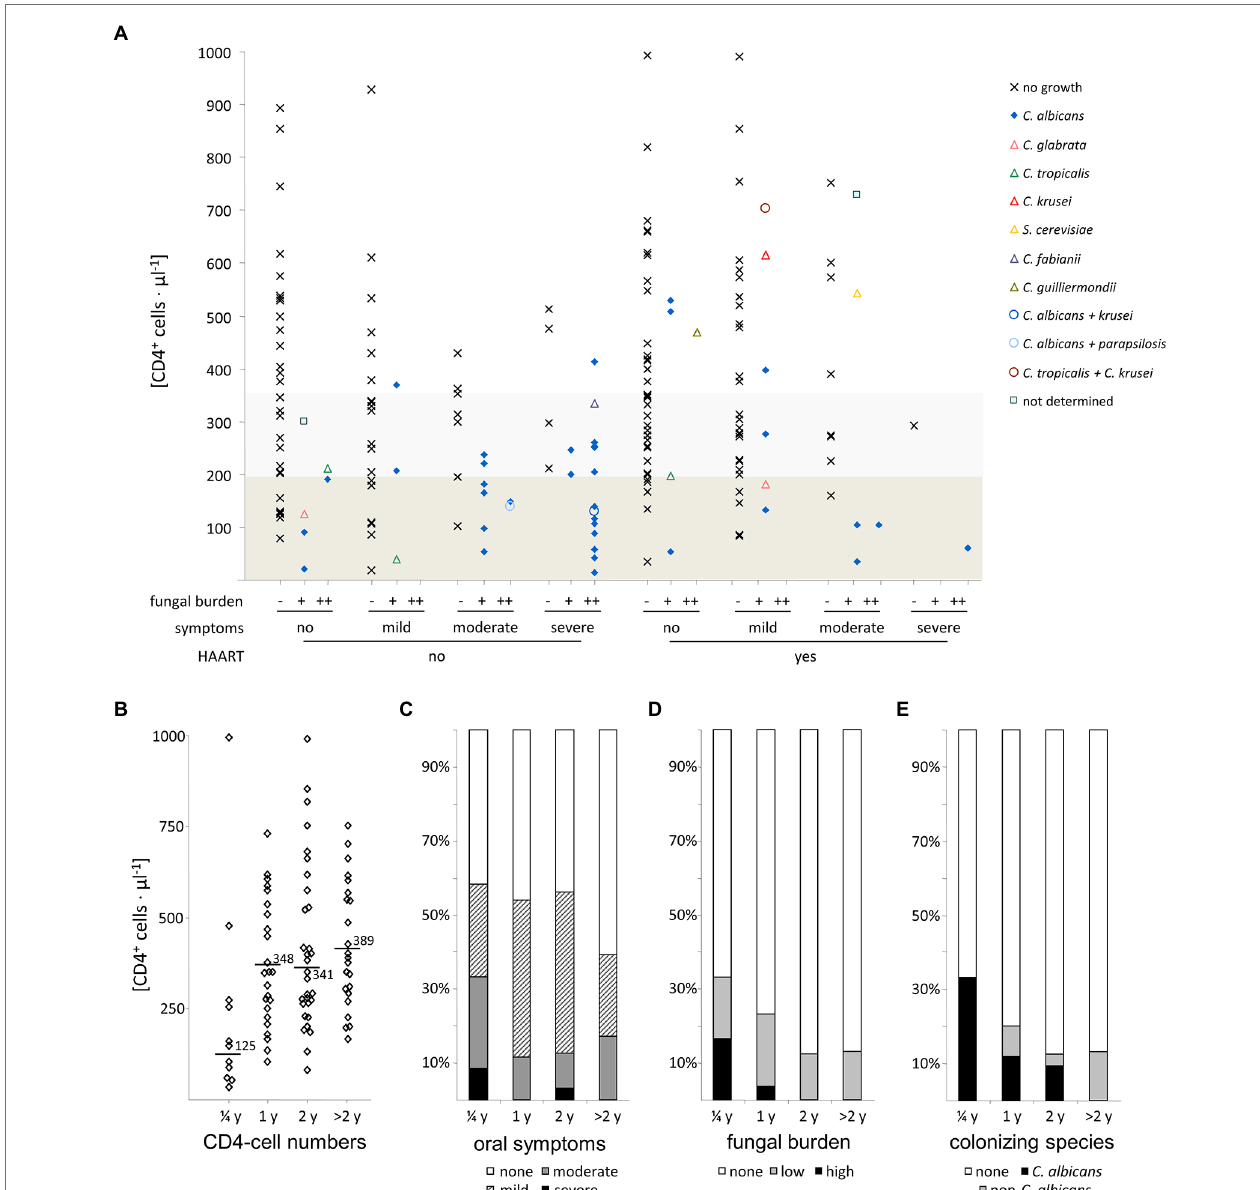
FIGURE 4 | Influence of Triomune HAART therapy on oral symptoms and yeast colonization in HIV-positive patients. (A) Association of CD4 + T-cell numbers with observational parameters investigated, (B) CD4 + T-cell numbers, (C) oral symptoms, (D) fungal burden, and (E) colonizing yeast species observed in HIV-positive patients with different lengths of Triomune HAART therapy (up to 0.25, 1, 2, and more than 2 years after initiation). Boxed regions in panel (A) denote CD4 + T-cell numbers below 200 cells/ μ l (dark grey) and 200–350 cells/ μ l (light grey). Numbers in panel (B) are mean